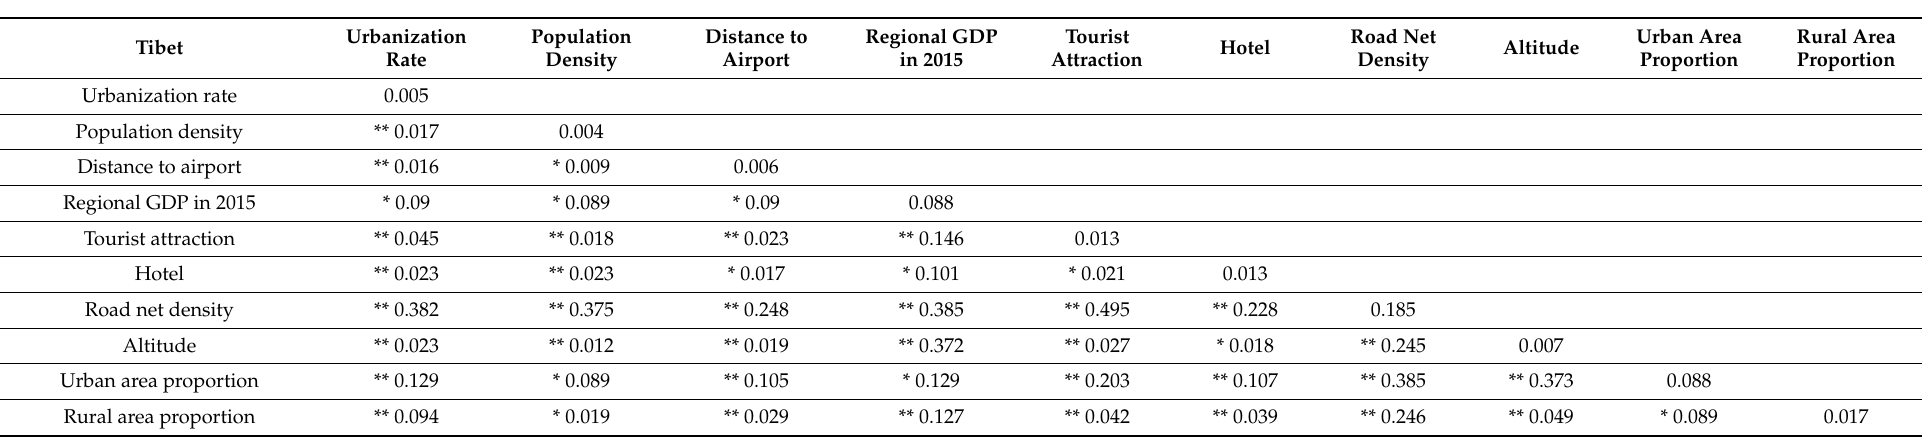
Table A2. q -Statistics of influential factor interactions in